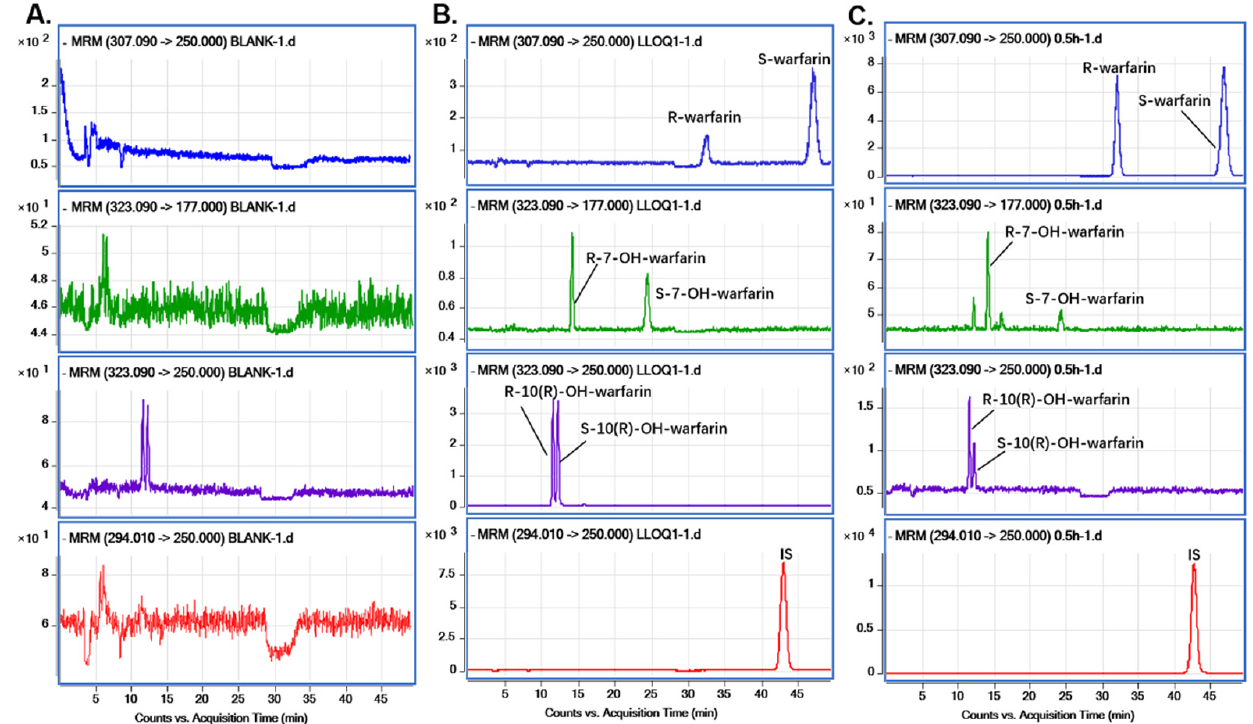
Figure 4. Typical multiple reaction monitoring chromatograms of blank plasma sample obtained from six-individual rats ( A ), a plasma sample of LLOQ containing S/R-warfarin, S/R-7-, 10(R)-0H-warfarin, and IS (diclofenac) ( B ), and real plasma sample collected from rat after 0.5 h oral administration of 2 mg/kg warfarin sodium ( C ).